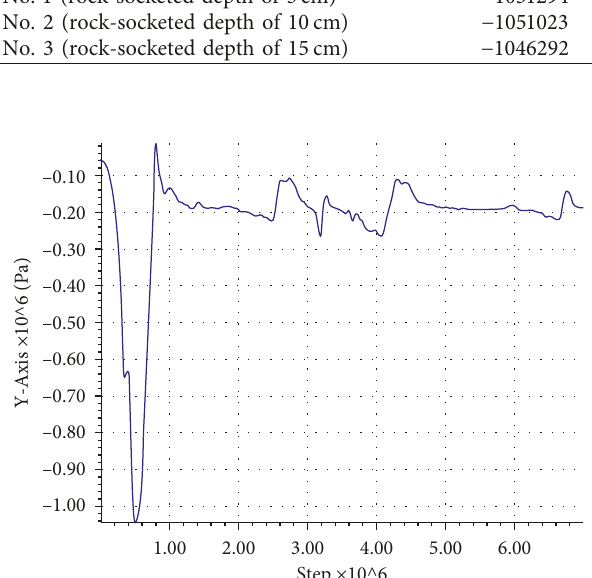
Figure 12: The time-course curve of the Earth pressure at the anti- slide pile No. 3.